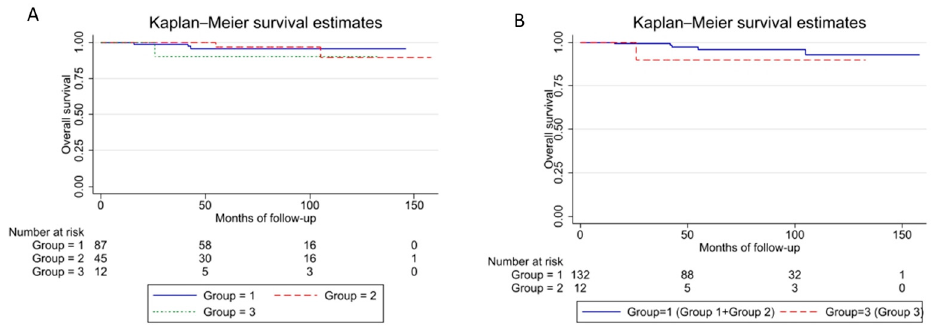
Figure 2. Kaplan–Meier curve stratified by histologic grade group. ( A ) Group 1 vs. Group 3 vs. Group 3, Log-rank test Pr > chi2 = 0.6061. ( B ) Group 1 + Group 2 vs. Group 3, Log-rank test pr =